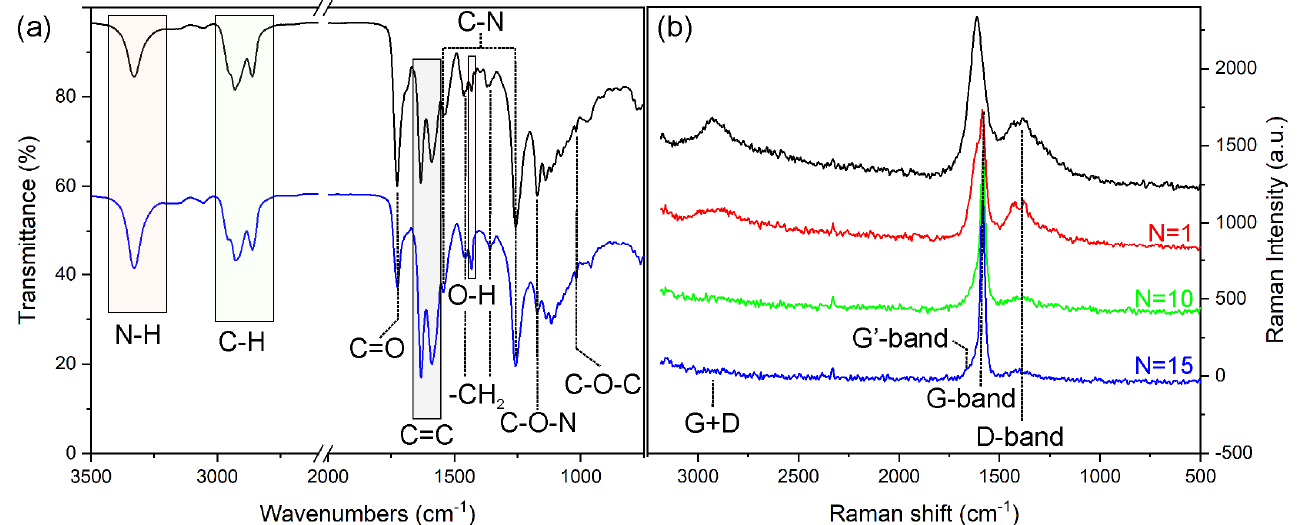
Figure 6. GO/PU top layer: ( a ) ATR spectra before (black line) and after laser irradiation (blue line); ( b ) Raman spectra before (black line) and after 1, 10, and 15 repeated laser treatments (red, green, and blue line, respectively).